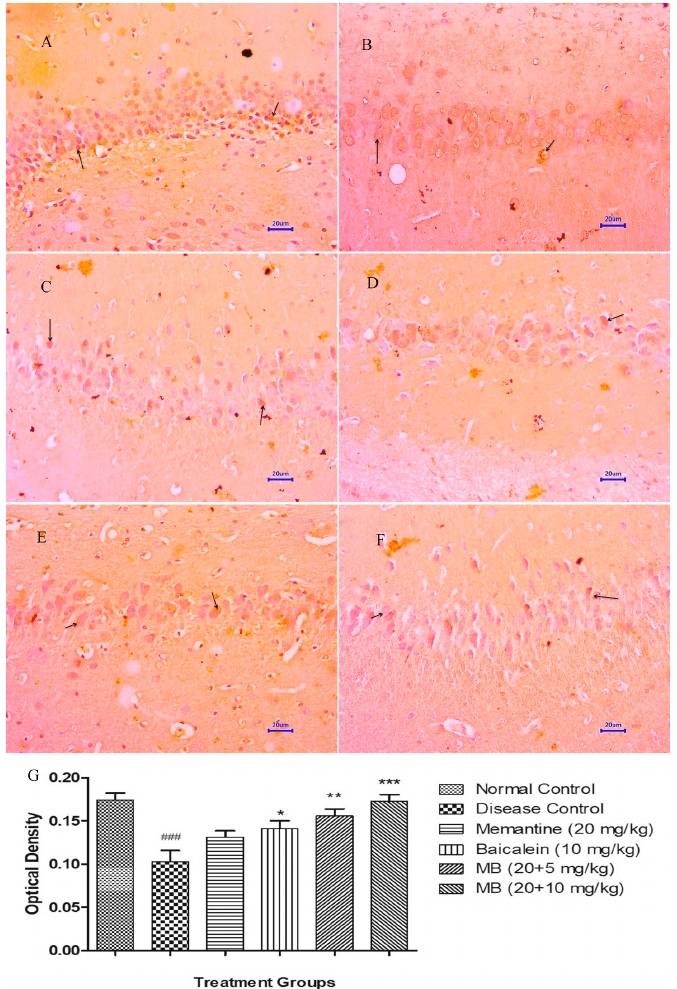
Figure 12. Effect of A β (1–42), baicalein and baicalein with memantine on BDNF expression in hip- pocampus tissue (400 × ). ( A ) Normal control: displaying moderate expression of BDNF (arrow) revealed by brown colouration in hippocampus. ( B ) Disease control: displaying mild expression of BDNF (arrow), revealed by brown colouration in hippocampus. ( C ) Memantine 20 mg/kg: displaying mild expression of BDNF (arrow), revealed by brown colouration in hippocampus. ( D ) Baicalein (10 mg/kg): displaying mild expression of BDNF (arrow) revealed by brown colouration in hippo- campus. ( E ) Memantine + Baicalein (20 + 5 mg/kg): displaying mild to moderate expression of BDNF (arrow), revealed by brown colouration in hippocampus. ( F ) Memantine + Baicalein (20 + 10 mg/kg): displaying moderate expression of BDNF (arrow), revealed by brown colouration in hippocampus. ( G ) OD data for ICH. Data are represented as mean ± SEM, where ### p < 0.001 indicates comparison with normal control, whereas * p < 0.05, ** p < 0.01 and *** p < 0.001 indicates comparison with disease control group; SEM, Standard Error of Mean; MB: memantine +